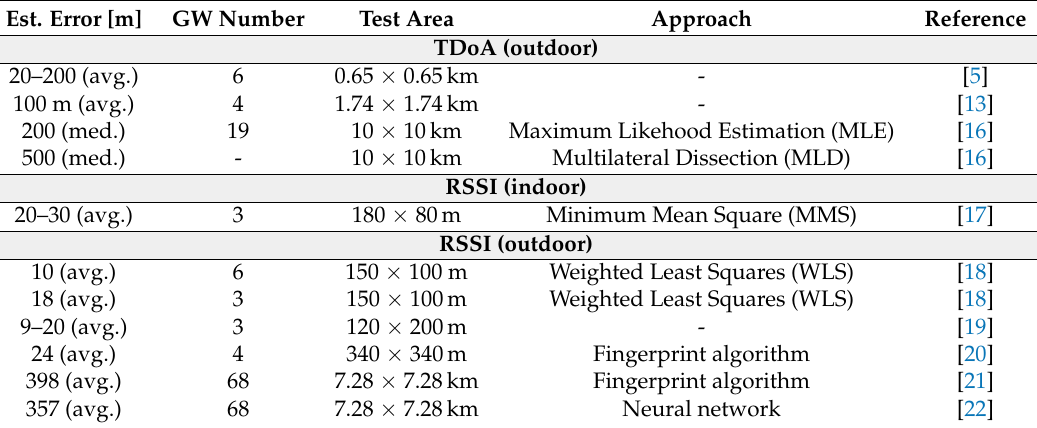
Table 1. Comparison of experiment setup and the achieved results in the related works.